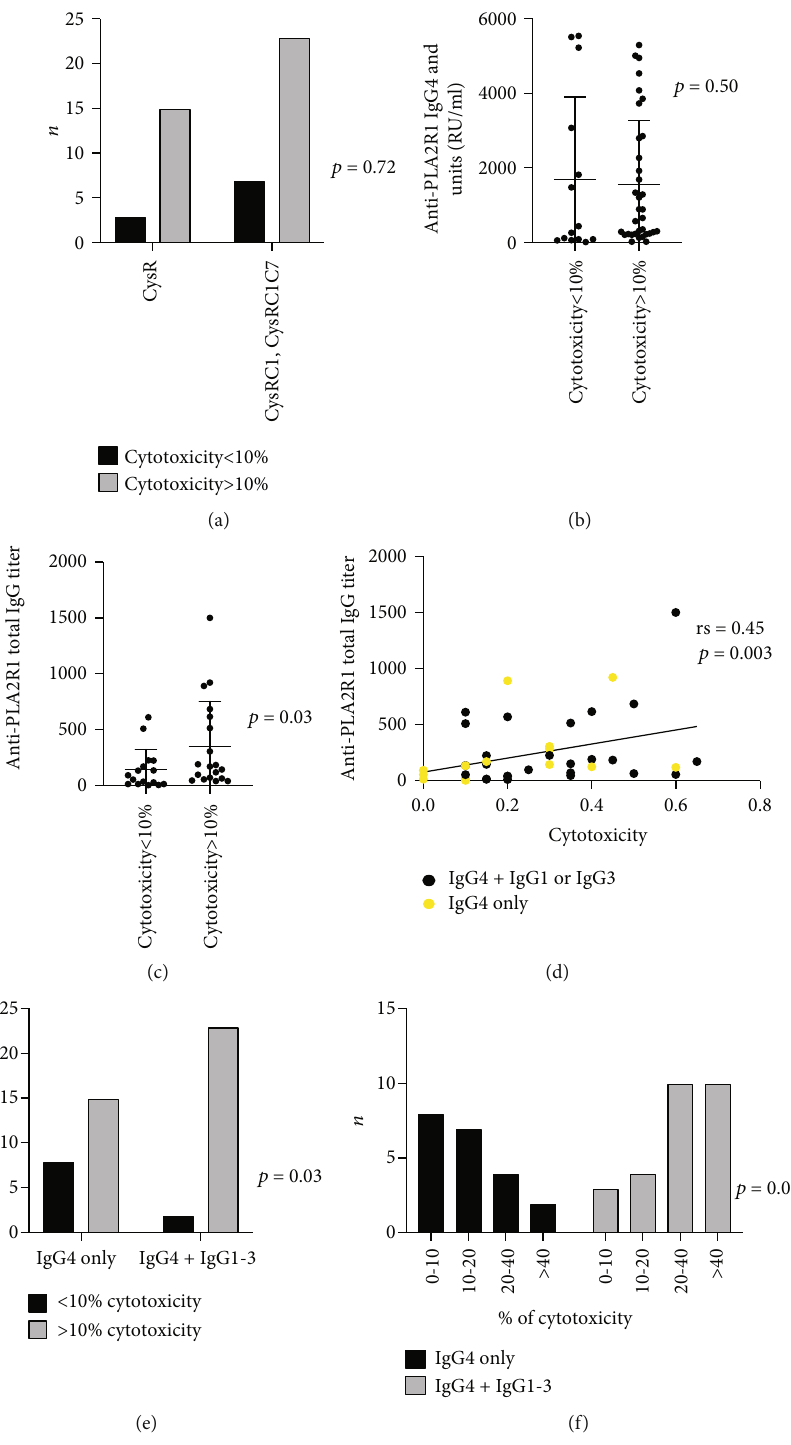
Figure 3: Predictive factors of anti-PLA2R1-mediated cytotoxicity in immuno fl uorescence cytotoxicity assay. (a) Relationship between anti- PLA2R1-induced cytotoxicity mediated by complement and epitope spreading pro fi le at baseline ( n = 48 ). CysR: immunized against CysR domain alone; CysRC1: immunized against CysR and CTLD1 domains; CysRC1C7: immunized against CysR, CTLD1, and CTLD7domains. (b) Relationship between anti-PLA2R1-induced cytotoxicity mediated by complement and Anti-PLA2R1 IgG4 (RU/ml) titers at baseline ( n = 48 ). (c) Relationship between anti-PLA2R1-induced cytotoxicity mediated by complement and Anti-PLA2R1 total IgG titer at baseline ( n = 48 ). (d) Correlation between Anti-PLA2R1 total IgG titer and complement-mediated cytotoxicity ( n = 48 ). (e) Anti-PLA2R1-induced cytotoxicity mediated by complement according to anti-PLA2R1 IgG subclasses at baseline ( n = 48 ). (f) Anti- PLA2R1-induced cytotoxicity mediated by complement regrouped by levels of cytotoxicity according to anti-PLA2R1 IgG subclasses at baseline ( n = 48 ). Note that patients with high level of cytotoxicity ( ≥ 40%) are predominantly